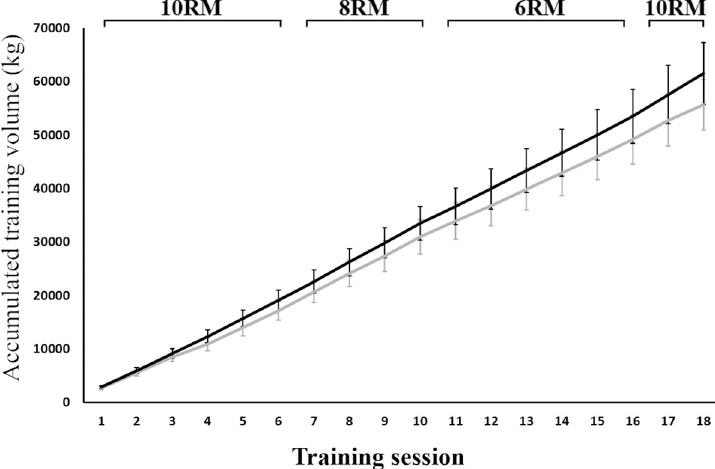
Fig 3. Accumulated volume (kg) throughout the training period for the SJ (grey line) and MJ group (black line). Error bars represent 95% confidence